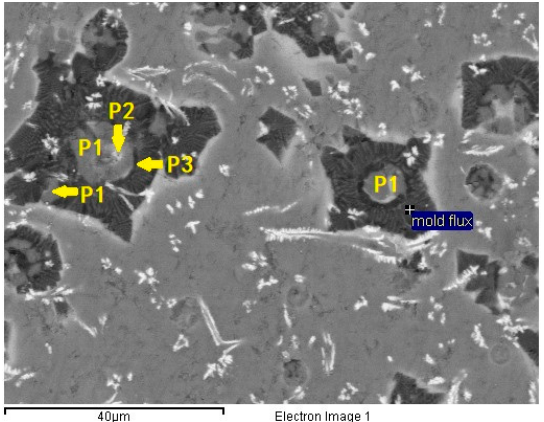
Figure 8. Details of crystals morphology after reaction lasted for 120 min.